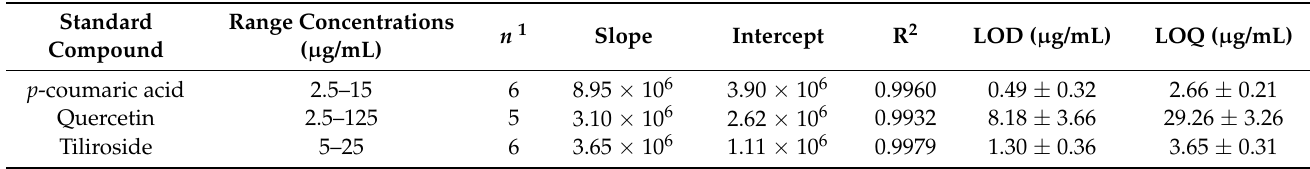
Table 4. Linearity, limit of detection (LOD) and limit of quantification (LOQ) of the three standards compounds used as